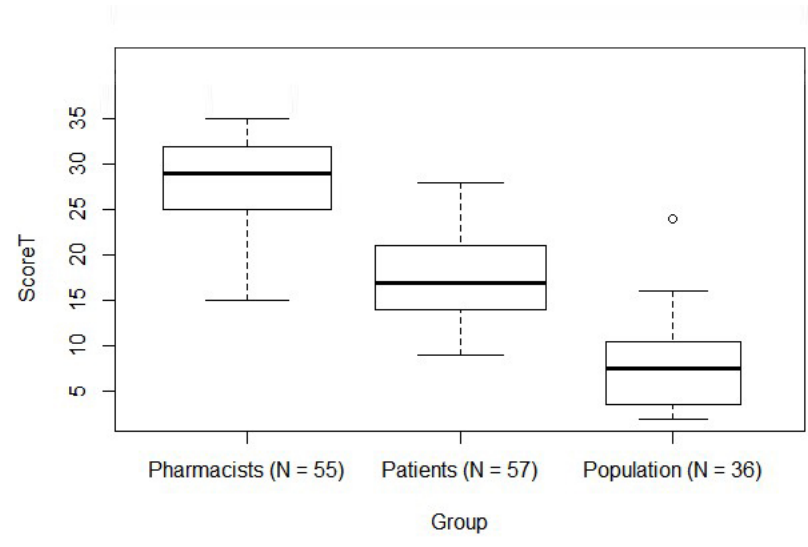
Fig. 1 - Total score comparison between groups/Tukey’s post hoc test showed significant differences (P<0.001) in comparing the means of all the groups (pharmacists vs. patients; pharmacists vs. population; patients vs.